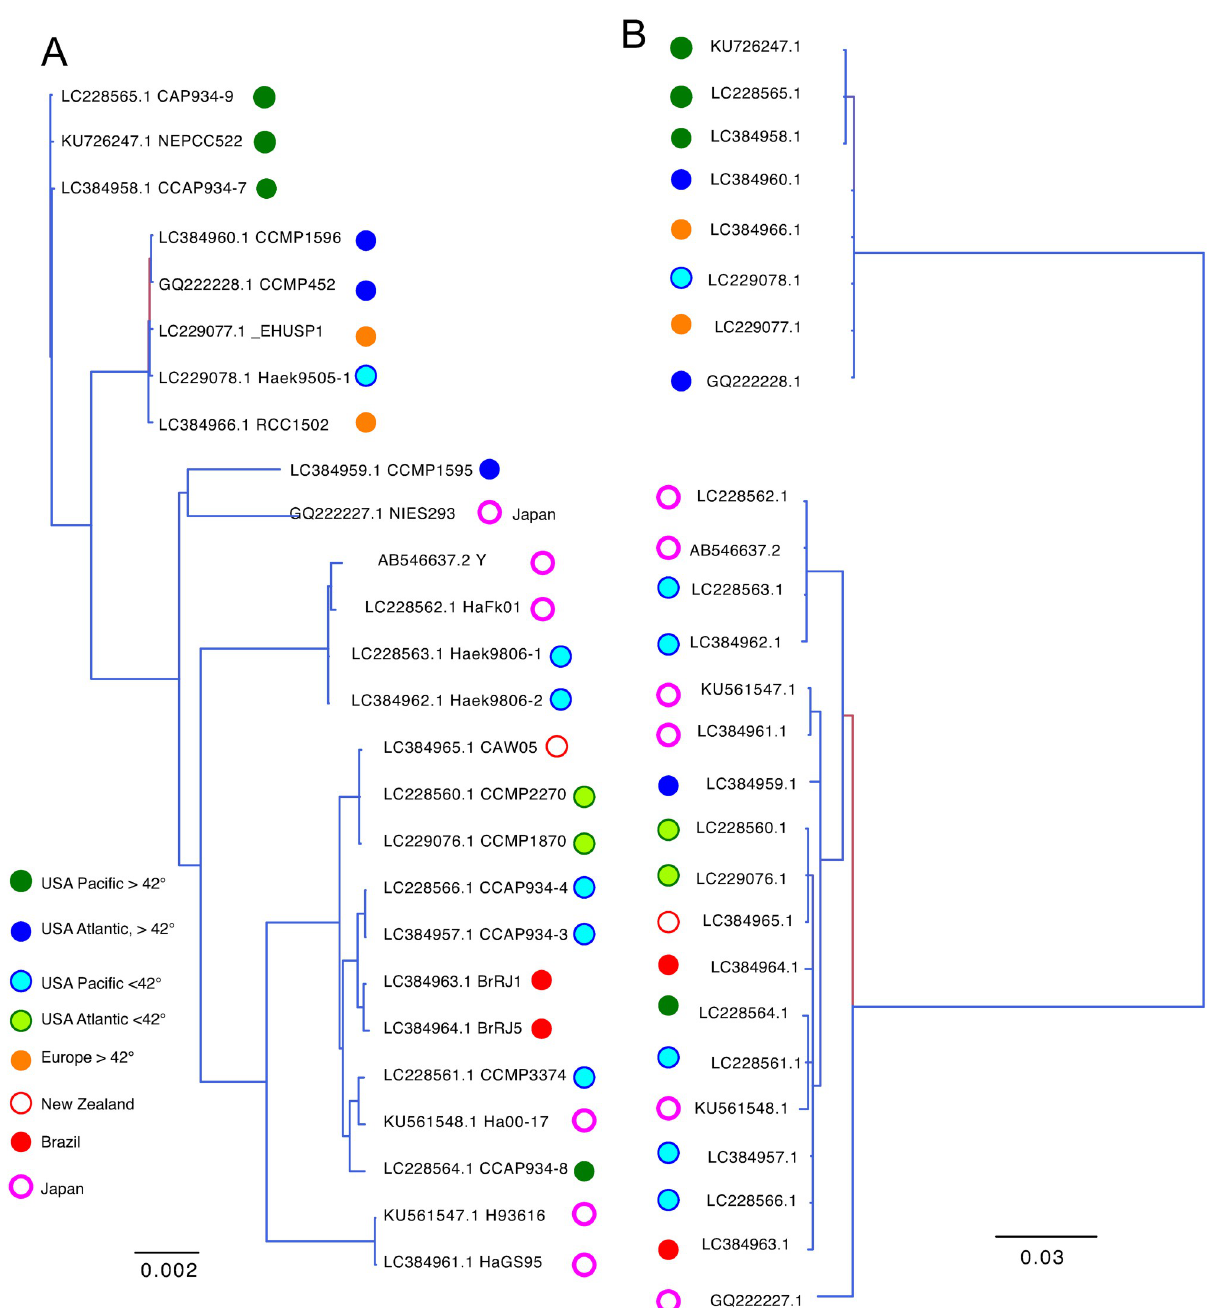
Fig 6. Comparison of the phylogenetic divergence of (A) H . akashiwo full-length mtDNA and (B) MtORFvar1. Branches with a posterior probability of 0.5 to 1.0 are expressed in color as indicated. Each branch is color-coded by the geographic origin of the isolate, as indicated in (A).